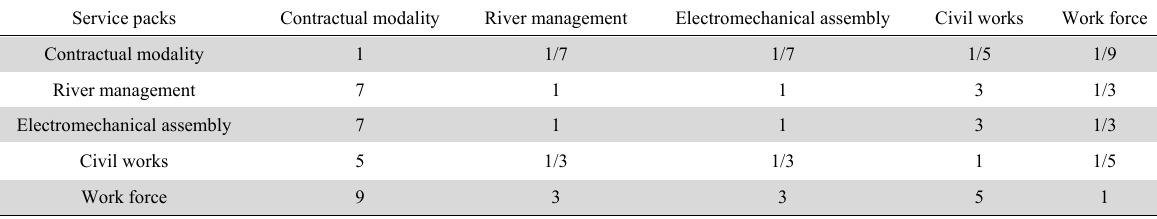
Table 2 Pairwise comparison matrix of the service packs from the contracts and civil works manager’s perception Service packs